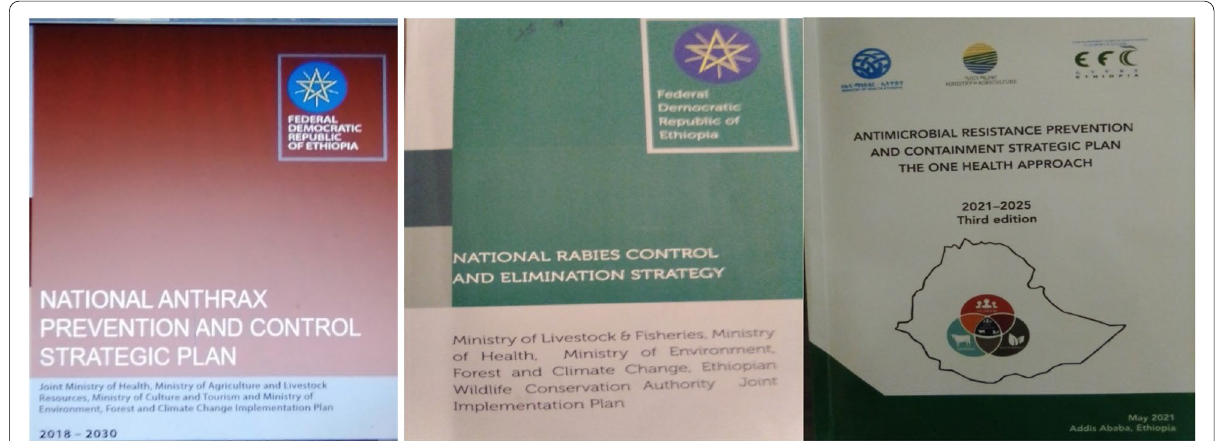
Fig. 5 Some of validated One Health approach strategic documents (obtained from Ministry of Agriculture with permission)